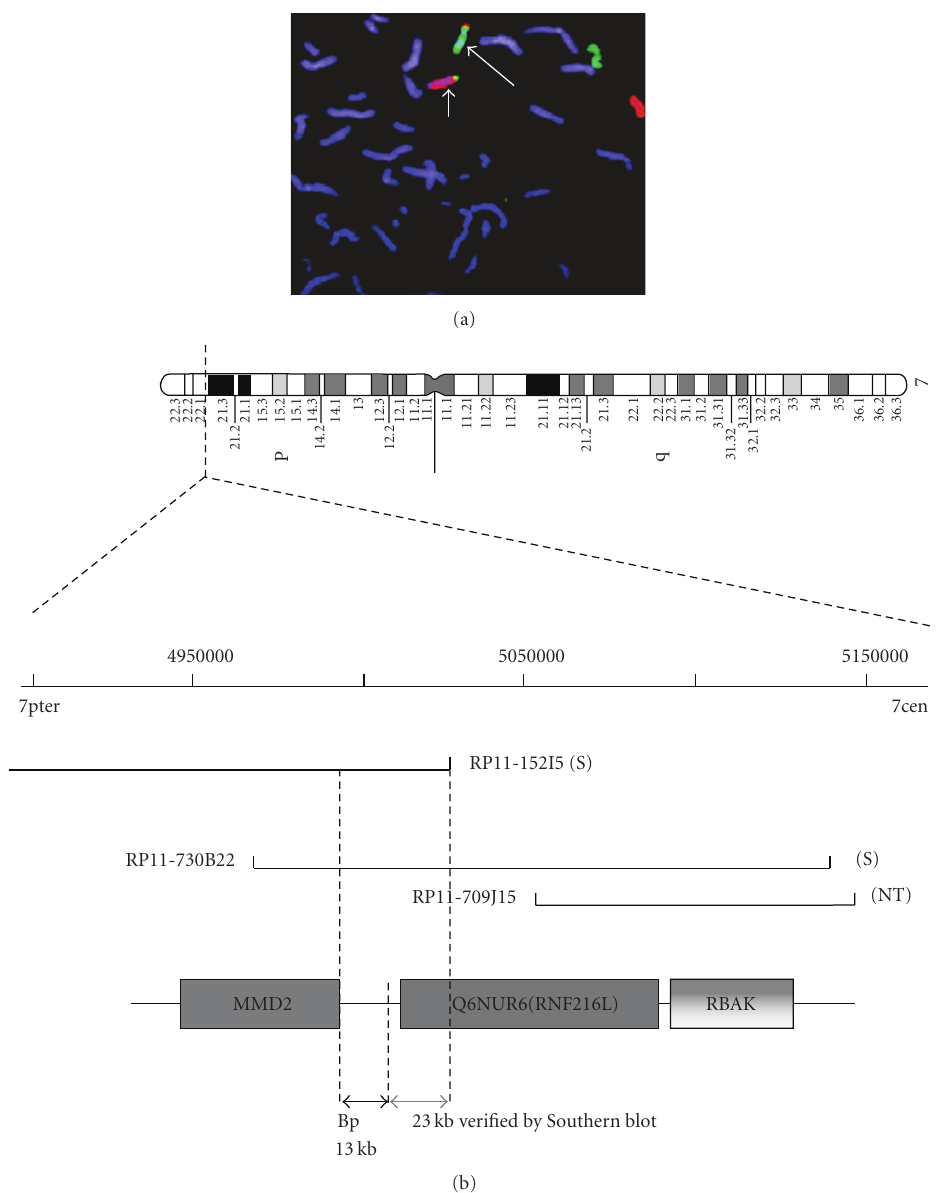
Figure 1: Physical mapping of the breakpoint on chromosome 7. (a) Dual color painting using directly FITC labelled (green) chromosome 7 paint and Rhodamine labelled (red) chromosome 16 paint. Both derivatives 7 and 16 (arrow) show clear evidence of a reciprocal exchange of chromatin from distal 7p and distal 16p, respectively. (b) Physical map of the genomic region 7p22.1 derived from the October 2009 version of the UCSC Genome Browser (http://genome.ucsc.edu/). The genomic clones covering the region flanking the translocation breakpoint are indicated by black lines (S: spanning, NT: non-translocated). The breakpoint (Bp) region is represented by an arrow. The genomic location of candidate genes is represented by